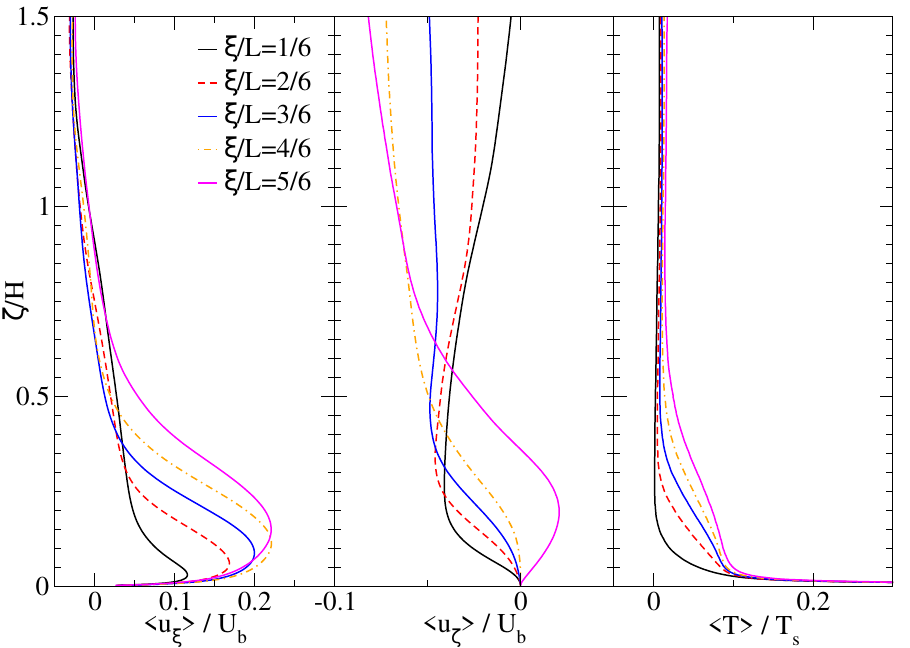
Figure 6. Non-dimensional mean slope-parallel velocity u ξ , slope-normal velocity u ζ and temper- ature perturbation at selected lines perpendicular to the slope: five levels equally spaced from the slope base ξ / L = 0 to its apex ξ / L =